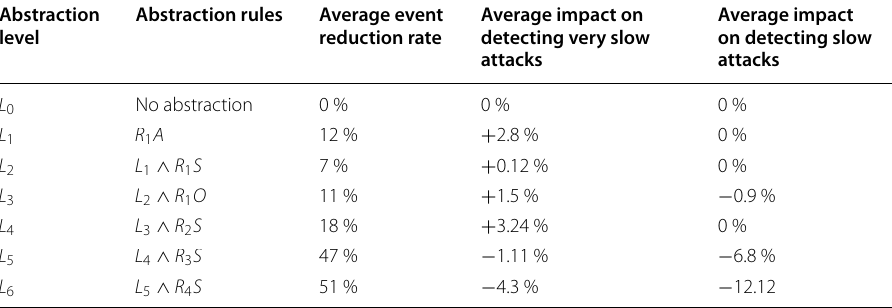
Table 8 Event abstraction levels Abstraction